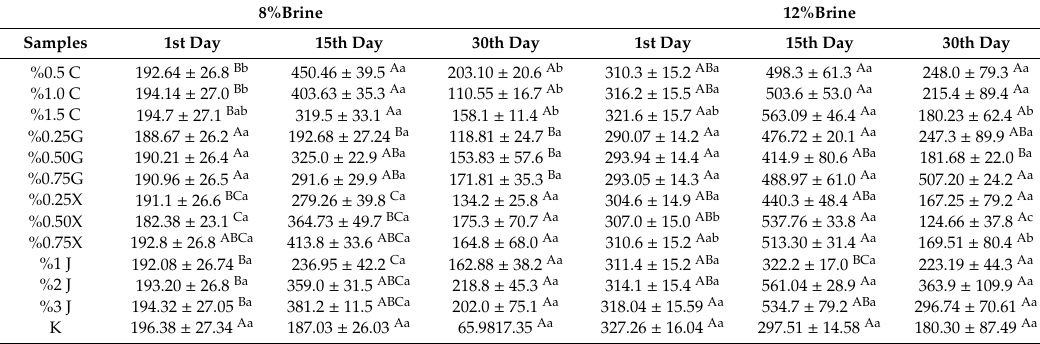
Table 10. Gumminess (g) of cheese samples during storage.